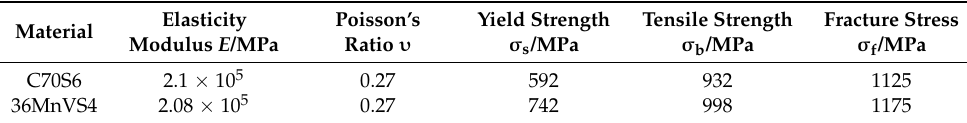
Table 2. Mechanical Properties.